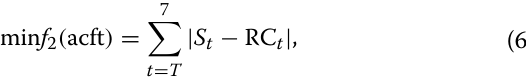
for estimating water temperature upstream and downstream of +